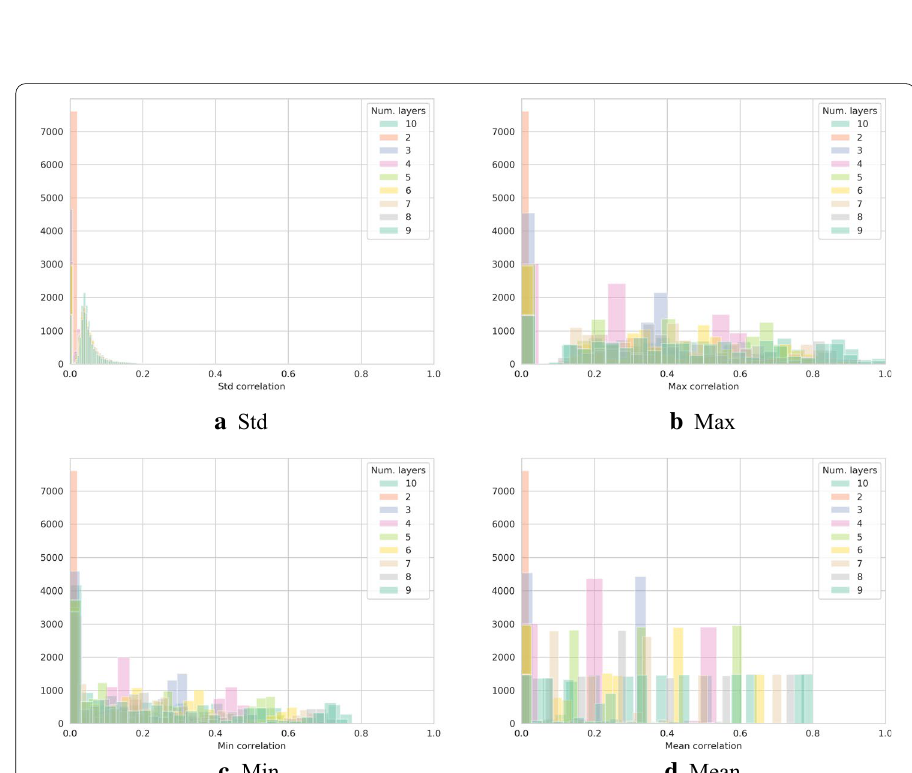
Fig. 28 Results of correlation analysis. It can be observed that the larger layers are subject to the most dispersed correlation distributions (Std peak in ( a )). Further, when considering only pairs of layers, very little correlation was observed in a large body of generated networks, indicating that by increasing the number of layers, correlation also